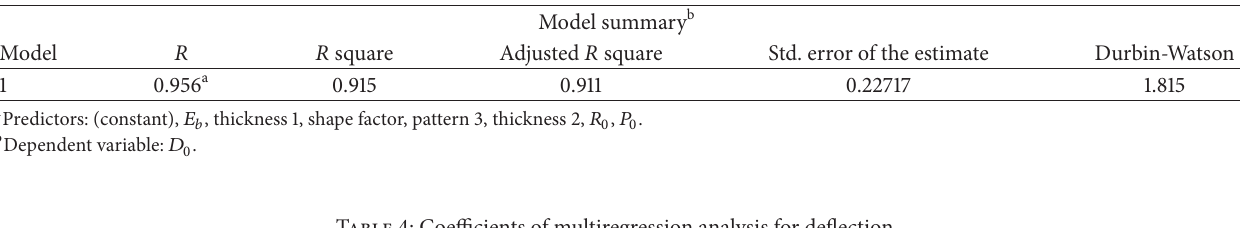
Table 4: Coefficients of multiregression analysis for deflection.